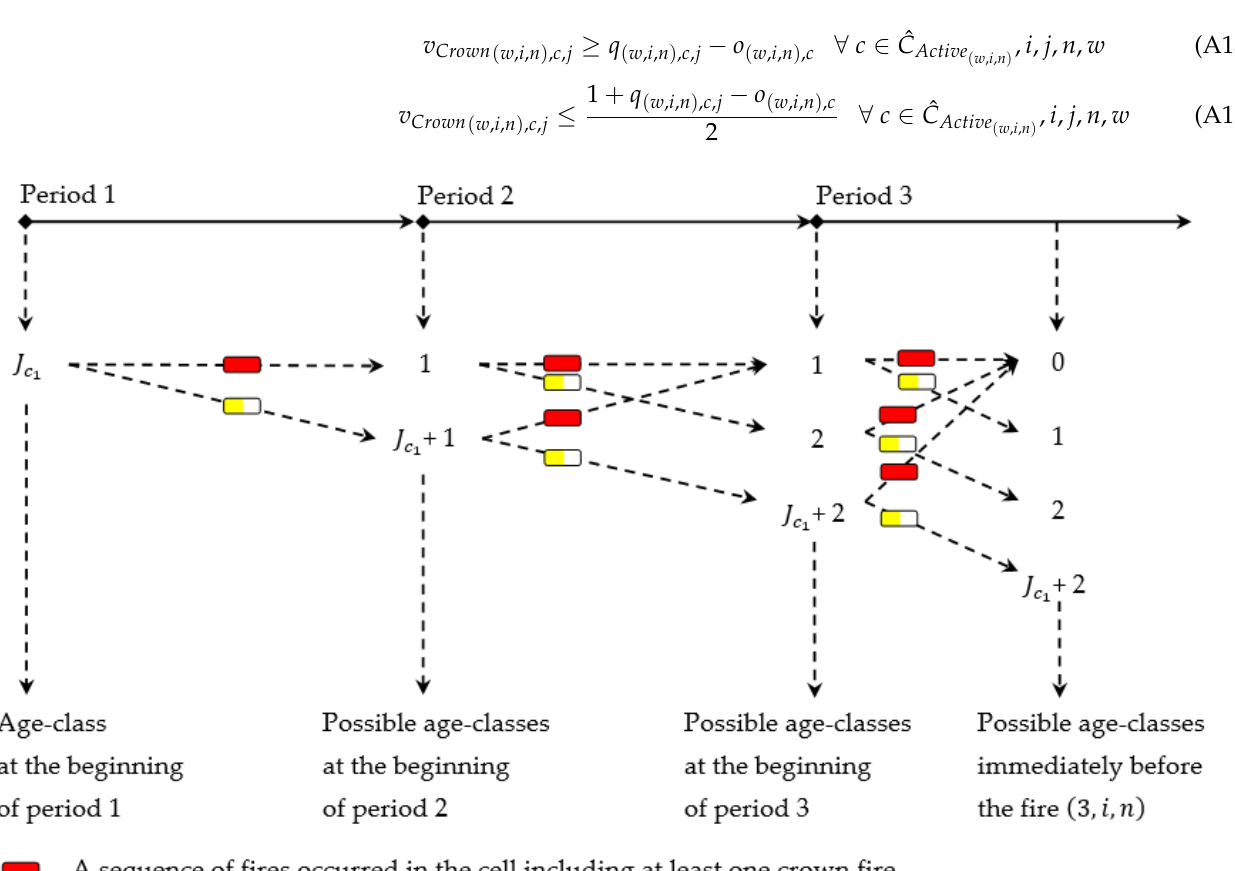
Figure A3. Possible age-classes of the forest in a cell at different times during a three-period planning horizon, assuming the forest age-class in this cell is J c at the beginning of the first period. 1